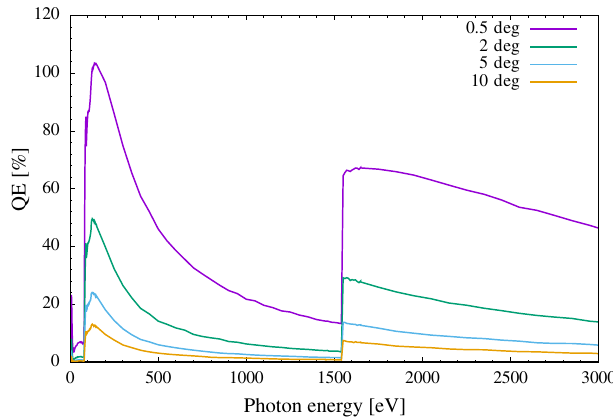
FIG. 19. Electron production rates as a function of azimuthal production location on the vacuum chamber wall for (a) field-free regionsand(b)dipoleregionsinunits ofelectrons = ð m · e þ · radian Þ . (Beam energy is 5.3